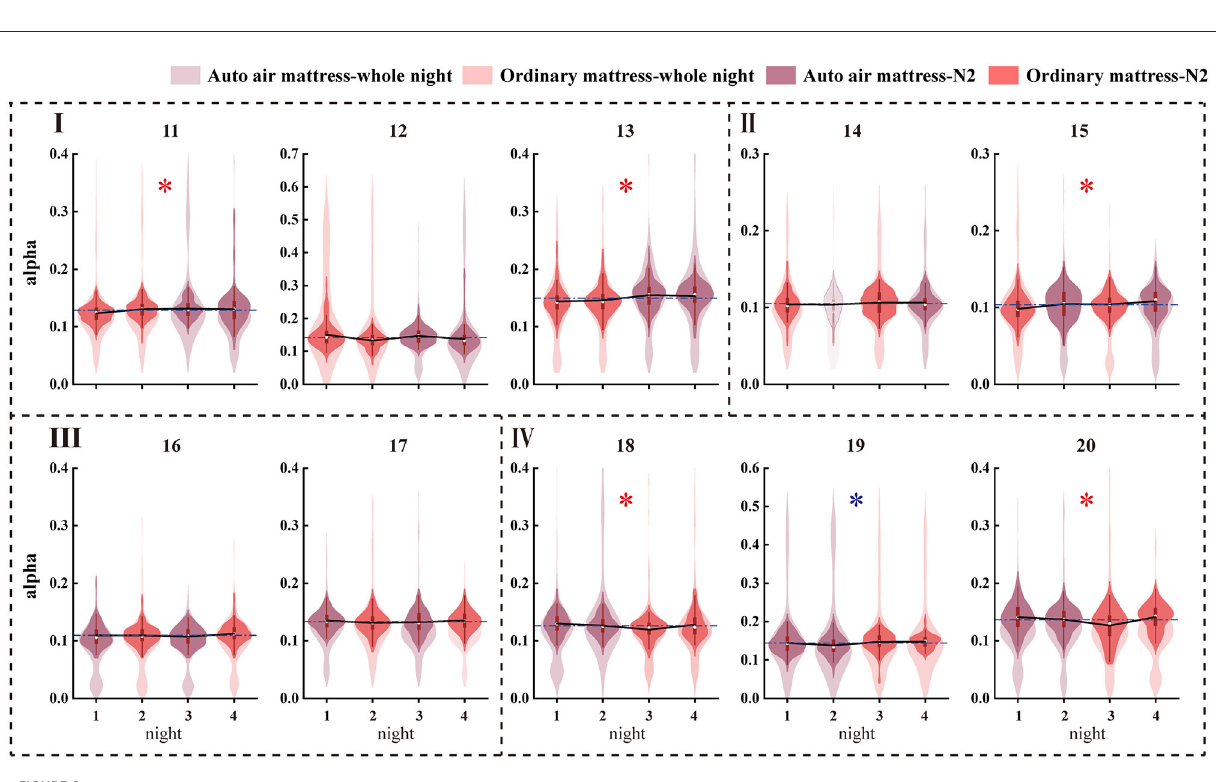
indicated decreased ANS activity during N3 sleep. Approximately half of the male participants also indicated decreased ANS activity, but its effect was less significant. Experimental nights had some of the same significant effects on both sexes. Reduced heart